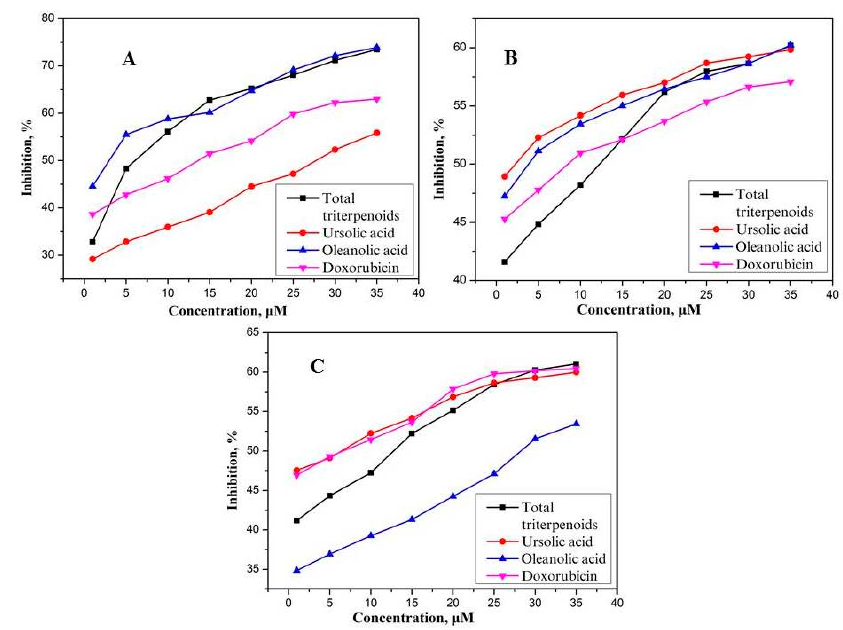
Figure 5. Dose response curves for inhibition of three human breast cancer cells; SK-Br-3 ( A ), T47D ( B ) and MCF-7 ( C ).